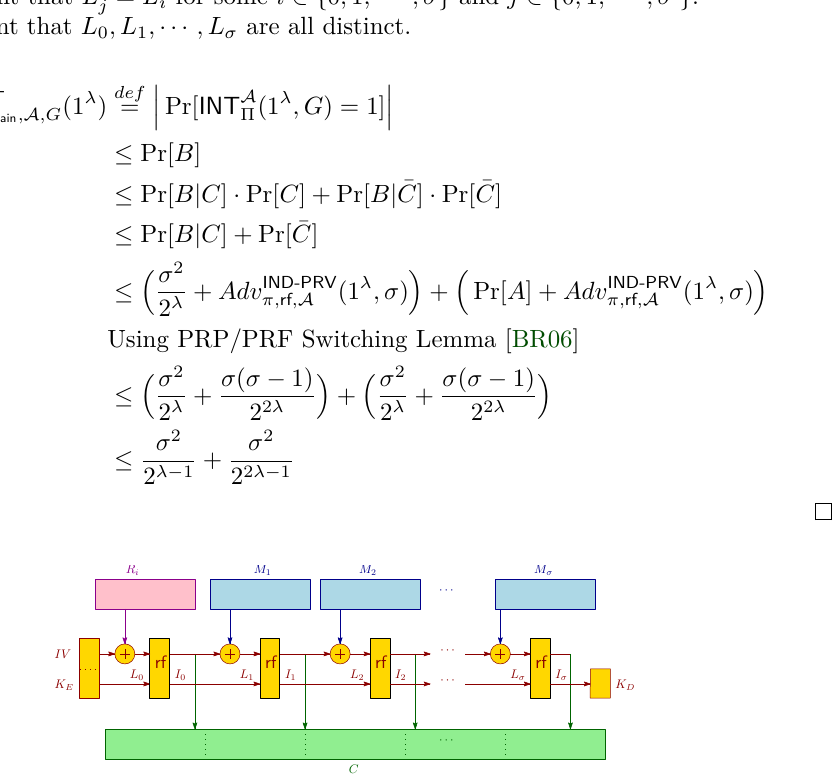
Figure 16: Construction C 0 obtained by replacing the random permutation π used in Chain the Construction C Chain by the random function rf